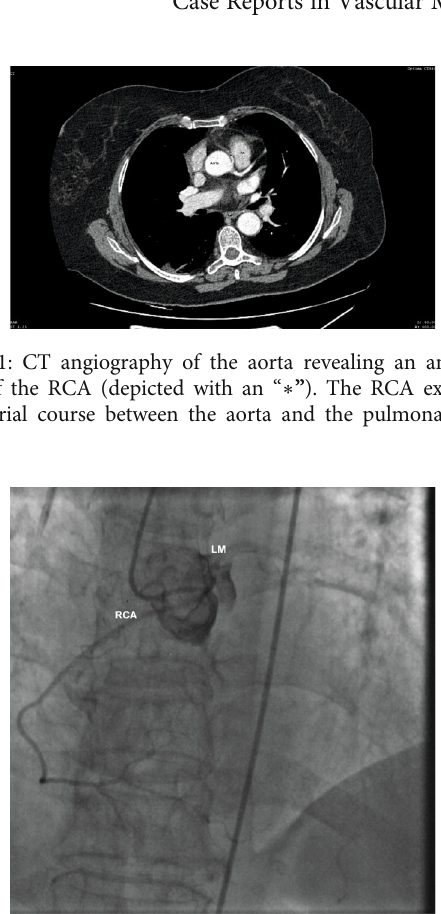
Figure 2: Coronary angiography con fi rming the anomalous aortic origin of the RCA from the left coronary sinus. LM: left